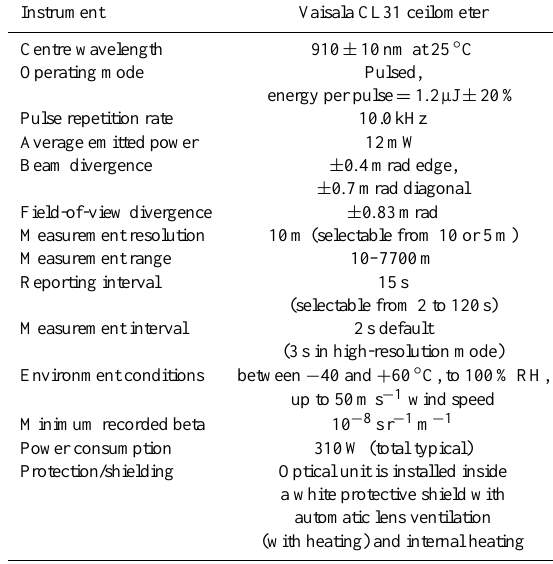
Table 4. Specifications of the HYDRANT Micro Rain